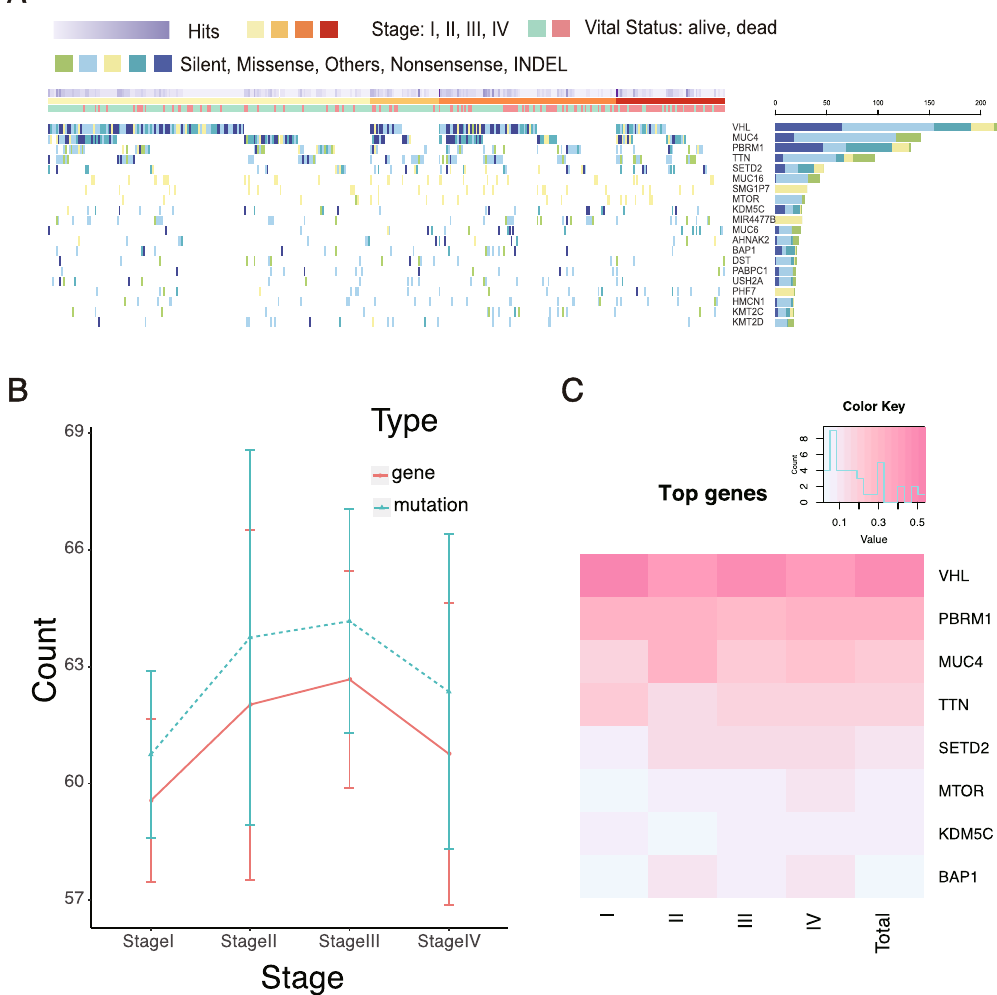
Figure 1. Overall features of KIRC mutation. ( A ) Distribution of the genes with high mutation frequency. ( B ) Mutation frequency and gene kinds per patient in different pathological stages. ( C ) Heat map of stage-specific frequency for the top 8 genes with high mutation